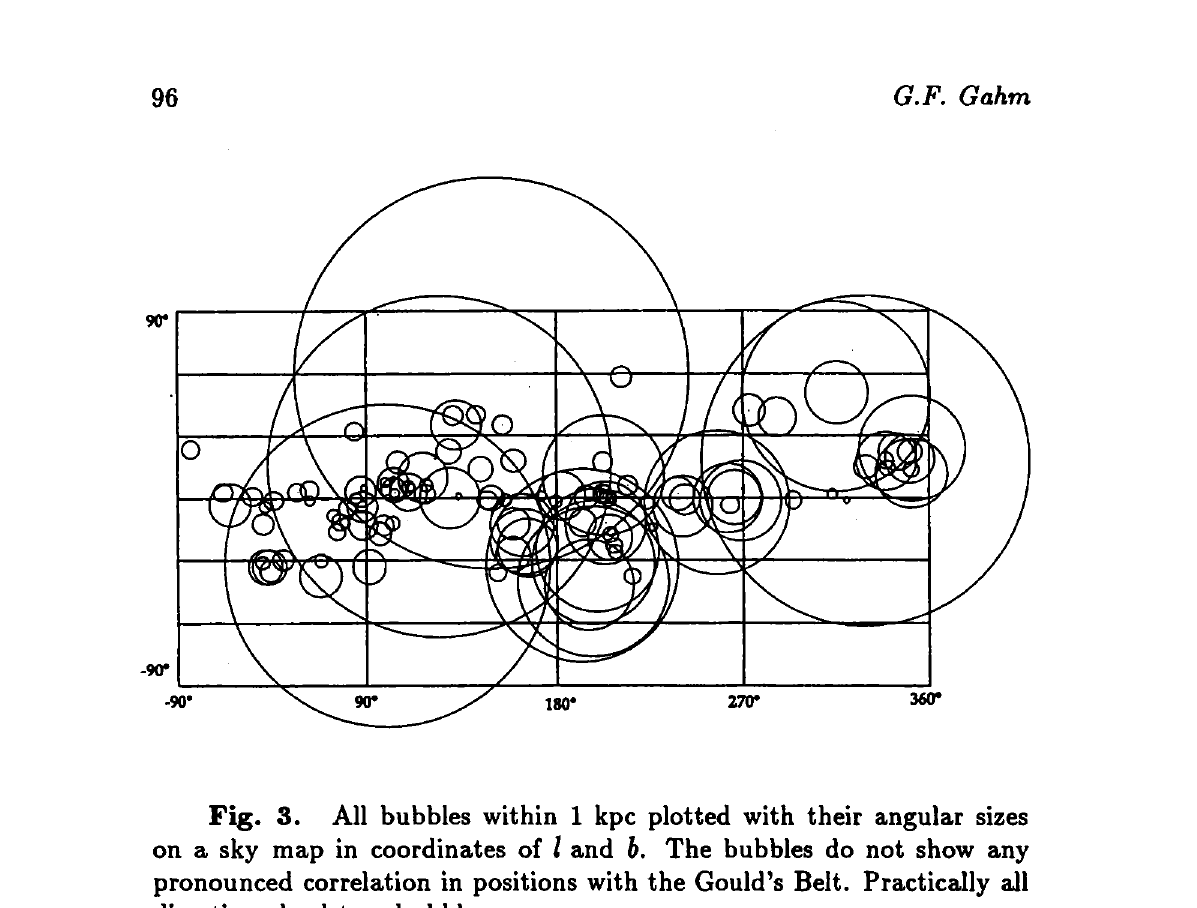
Fig. 3. All bubbles within 1 kpc plotted with their angular sizes on a sky map in coordinates of I and b. The bubbles do not show any pronounced correlation in positions with the Gould's Belt. Practically all directions lead to a